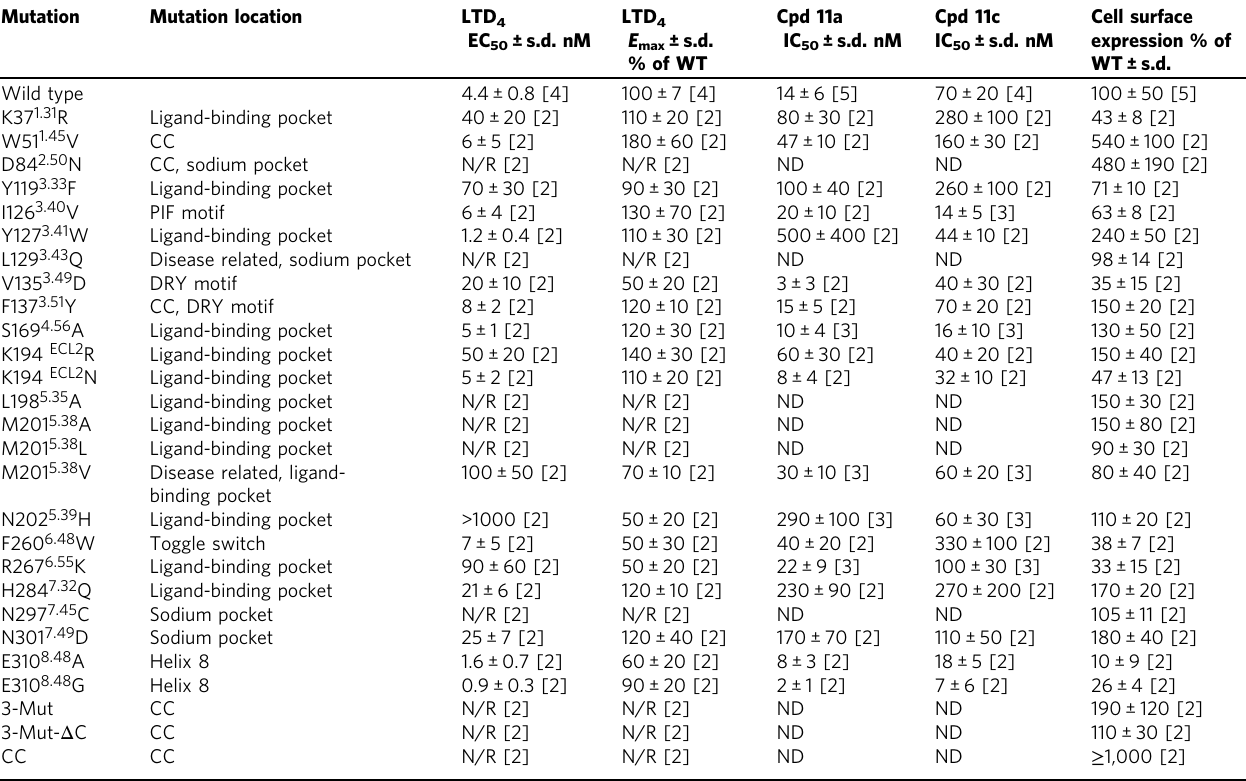
Table 1 Signaling and cell surface expression data for CysLT 2 R.